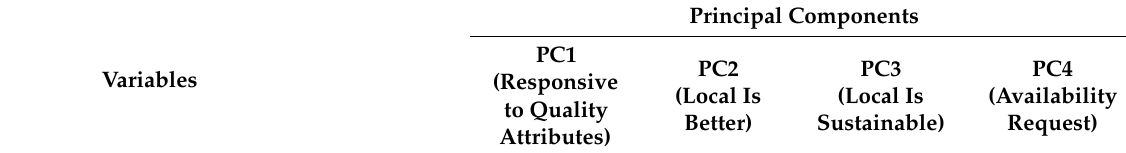
Table 2. Varimax rotated PCA: dairy products sustainability and quality components ( n = 543). Each component is named in accordance with the consumption models described by the significance of